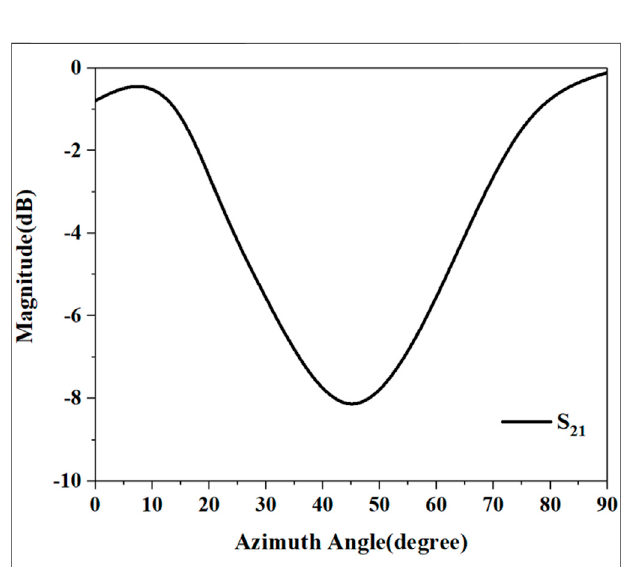
FIGURE9| There fl ectioncoef fi cientofanisotropicgratingwhenrotating the DPM counterclockwise.